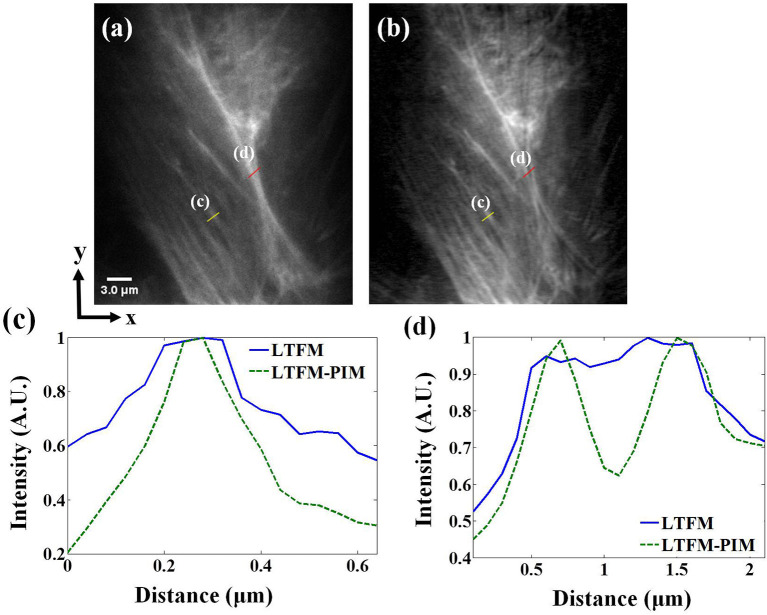
(a,b) LTFM and LTFM-PIM images of an MCF-10A human mammary epithelial cell, respectively. (c,d) Comparison of signal intensities along the yellow and red solid lines in (a,b). Gamma correction 0.5 was applied to enhance the visibility of mitochondria structures.